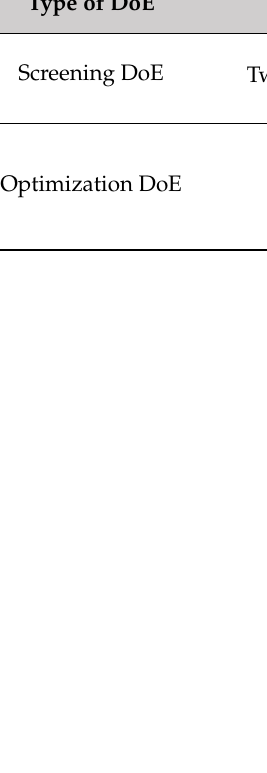
Table 4. Two-level FFD matrix for two (2 2 ), three (2 3 ), and four (2 4 ) experimental